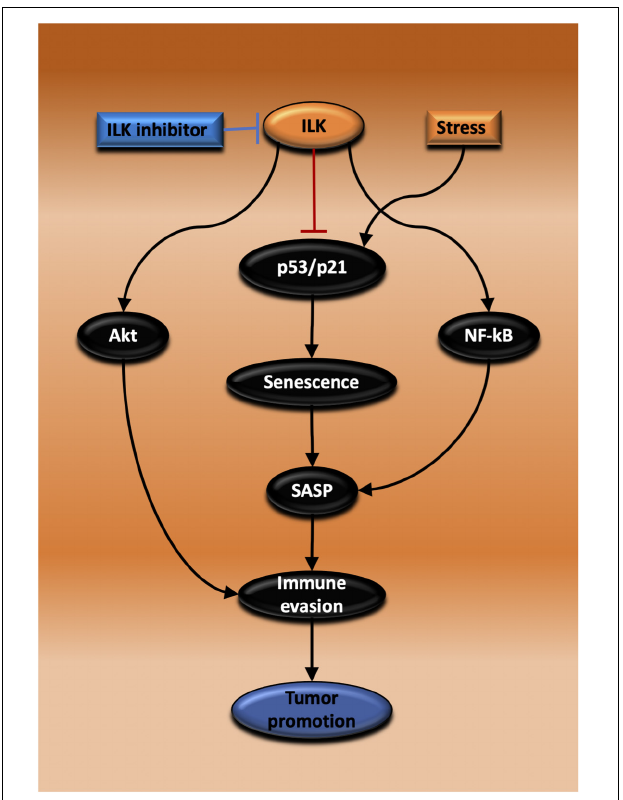
FIGURE 5 | Proposed mechanisms for the promotion of tumor growth by ILK via regulation of senescence and immunity. Inhibiting ILK could suppress and regress CRC growth by three possible mechanisms that are dependent on each other. In the first, ILK inhibition suppresses the activation of Akt, maintaining immune cell activation and tumor cell killing. In the second mechanism, ILK inhibition increases senescence induction via activating p53/p21, thereby inhibiting tumor growth. The third possibility relies on ILK inhibition and the consequent suppression of NF- κ B activation, a master regulator of SASP, reprogramming SASP secretion to induce immune